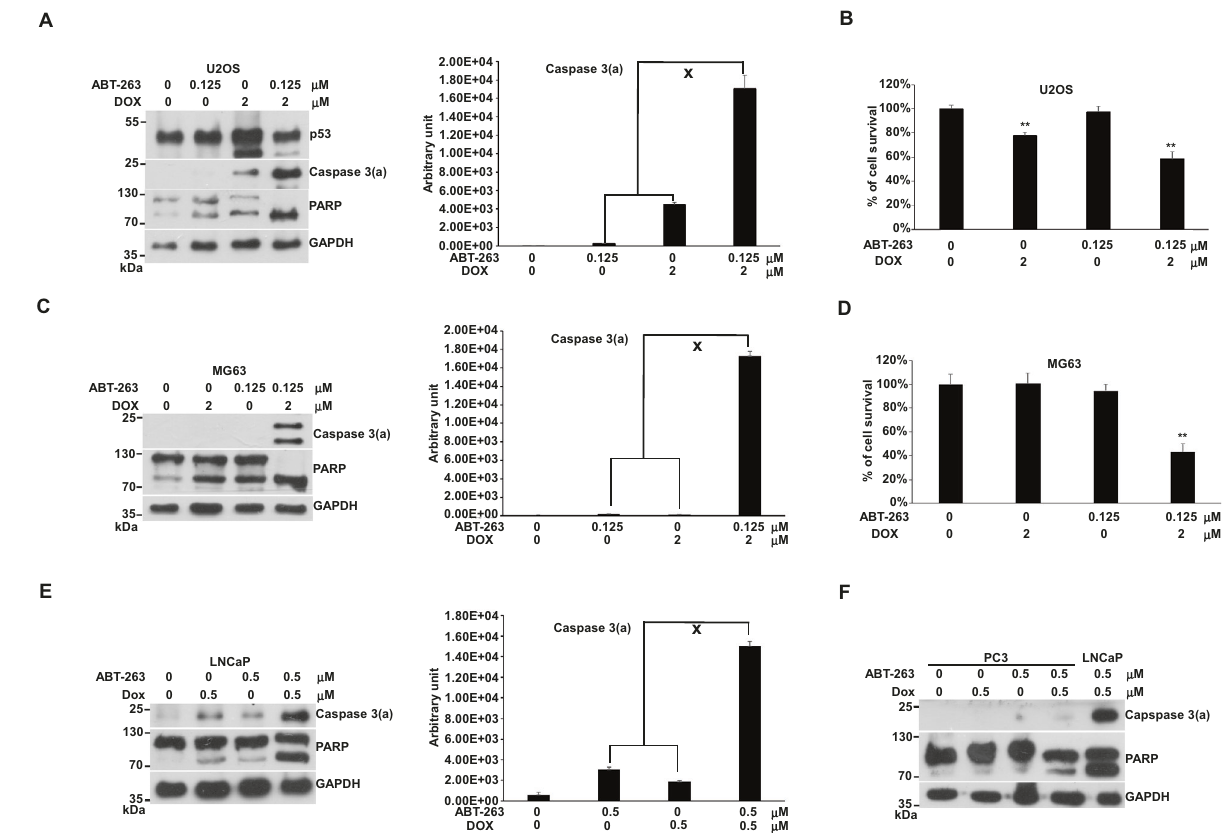
Fig. 4 Effects of the combination of DOX with ABT-263 on apoptosis in U2OS, MG63, LNCaP, and PC3 cells. Cells were incubated with ABT- 263, DOX, or a combination of both in 10-cm plates or 96-well plates for 24 h and harvested for western blotting or cell survival assay, respectively. The immunoblot images of p53 of U2OS and the immunoblot images of caspase 3(a) and PARP of U2OS and MG63 were shown. GAPDH served as a loading control. The immunoblot images of caspase 3(a) normalized to GAPDH were quantitated as shown beside the right side of the immunoblot image. The “ x ” indicated a synergistic outcome. The percentages of cell survival normalized to the cells without compound treatment were shown (** P < 0.01). The immune blots were cropped from different parts of the same gels and visualized by ECL with various exposure conditions dependent on the activity of antibodies. Representative blots from triplicate experiments were shown. A Immunoblot image of U2OS. B U2OS cell survival. C Immunoblot image of MG63. D MG63 cell survival. E Immunoblot image of LNCaP. F Immunoblot image of